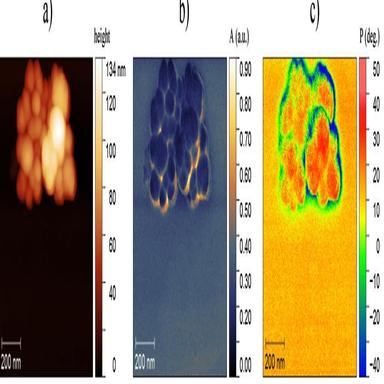
Silica nanoparticles doped with cytochrome c (Si-NP Cyt C); (a) AFM topography; (b) s-SNOM 3rd harmonic amplitude; (c) s-SNOM 3rd harmonic phase.